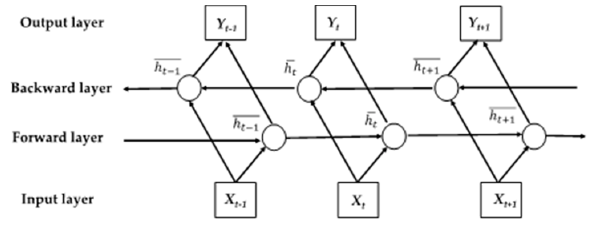
Figure 6. Architecture of the BiLSTM cell.